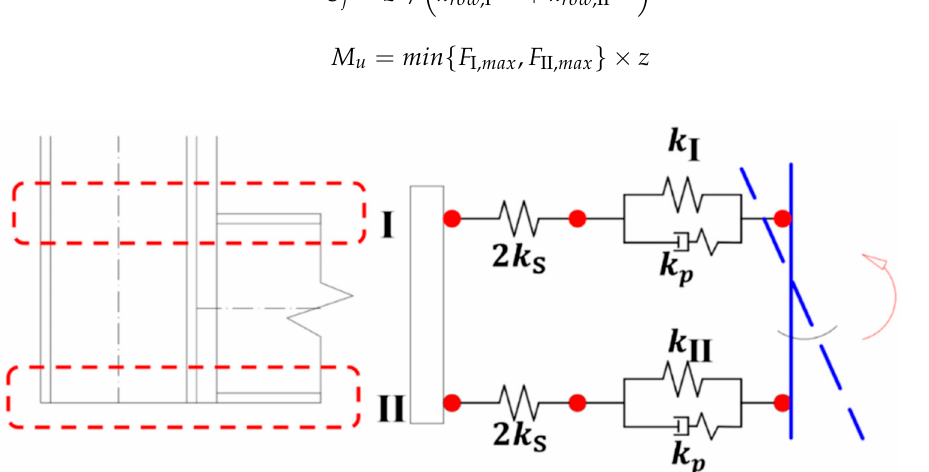
Figure 40. Spring-based model for intramodule connections.